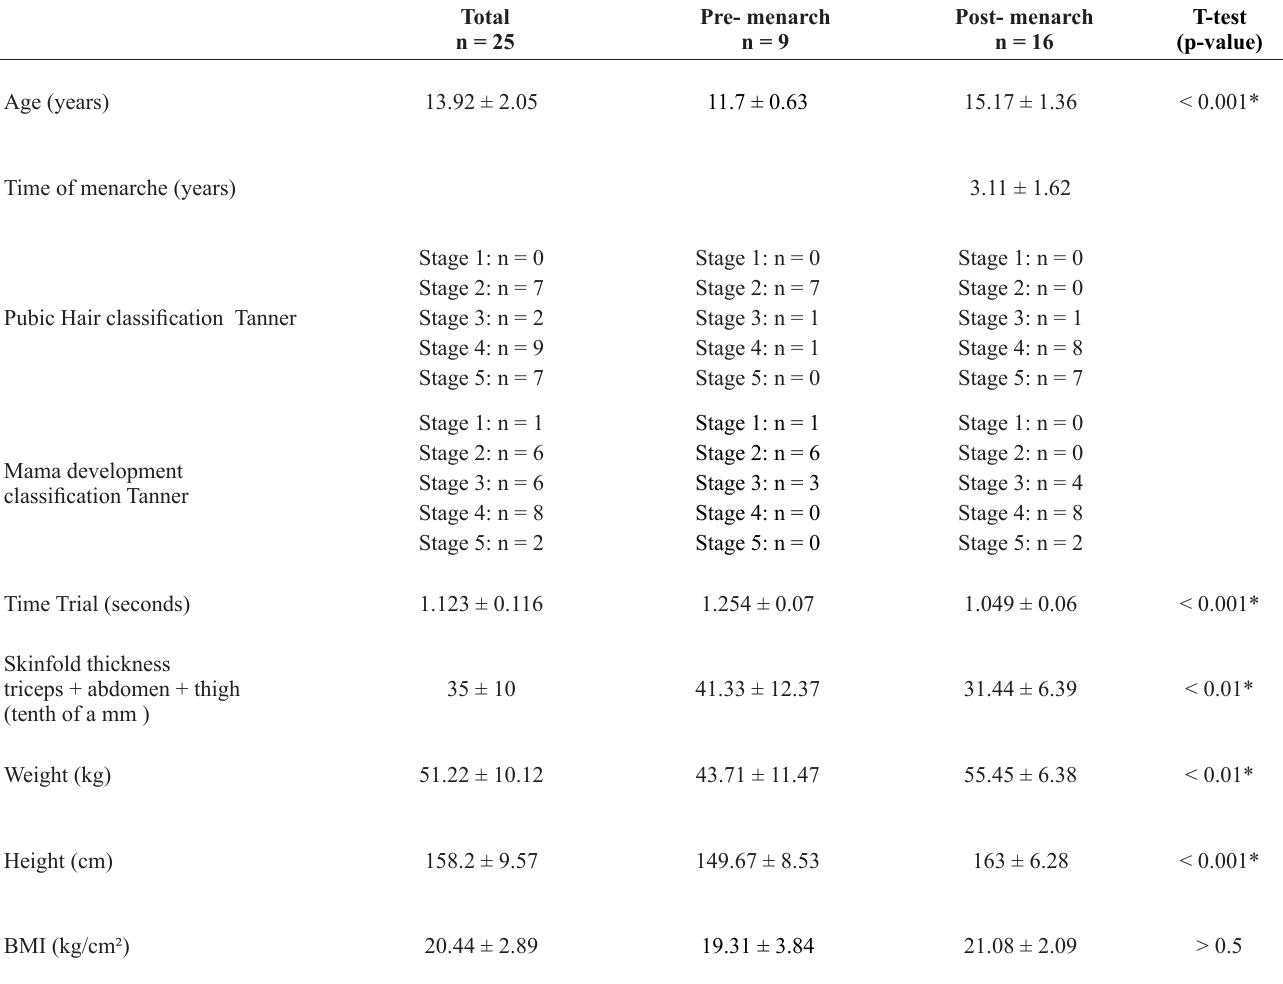
Table 1 - Personal, maturational, morphologic and motor performance of the